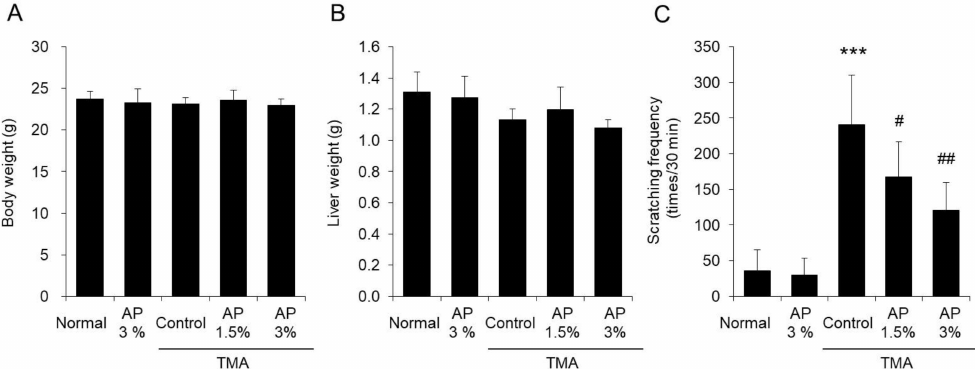
Figure 2. Scratching behavior. Mice with atopic dermatitis induced by repeated application of TMA were given a diet with AP. The body weight ( A ), liver weight ( B ), and scratching behavior ( C ) were measured (mean ± SD, N = 8, *** p < 0.001 vs. normal group, # p < 0.05 vs. TMA-control group, ## p < 0.01 vs. TMA-control group).